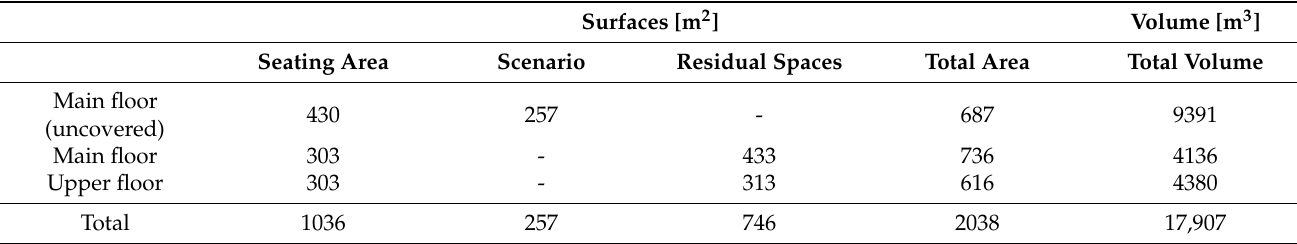
Table 1. Volumes and area of the Palace.